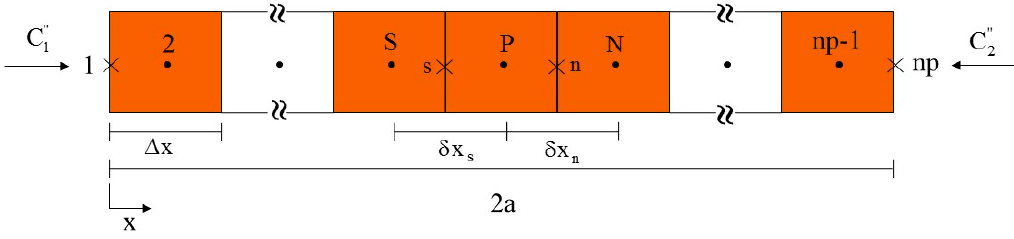
Figure 2. Schematic representation of the computational domain.